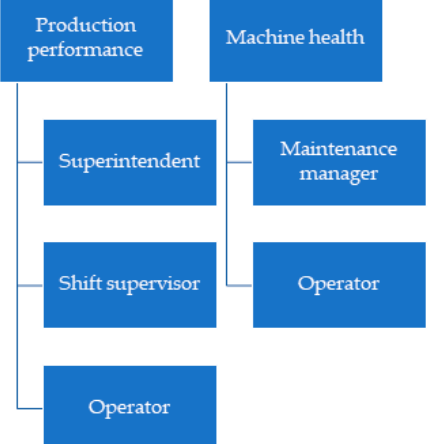
Figure 5. Interests of persons in a mining operation.